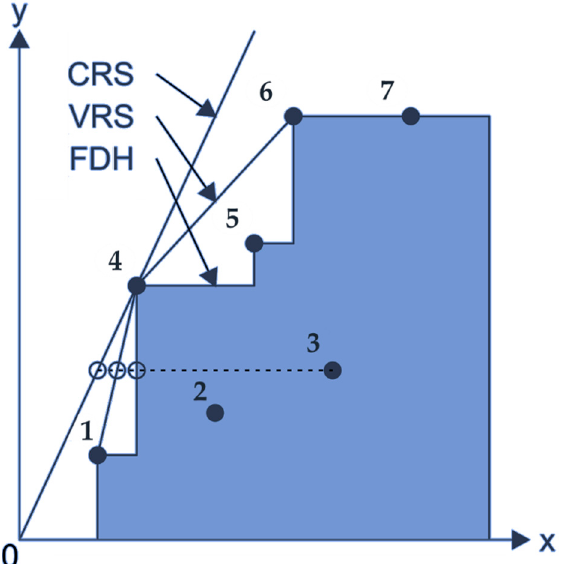
Figure 2. Production possibility sets in increasing returns-to-scale (IRS), decreasing returns-to-scale (DRS), and constant returns to scale (CRS).